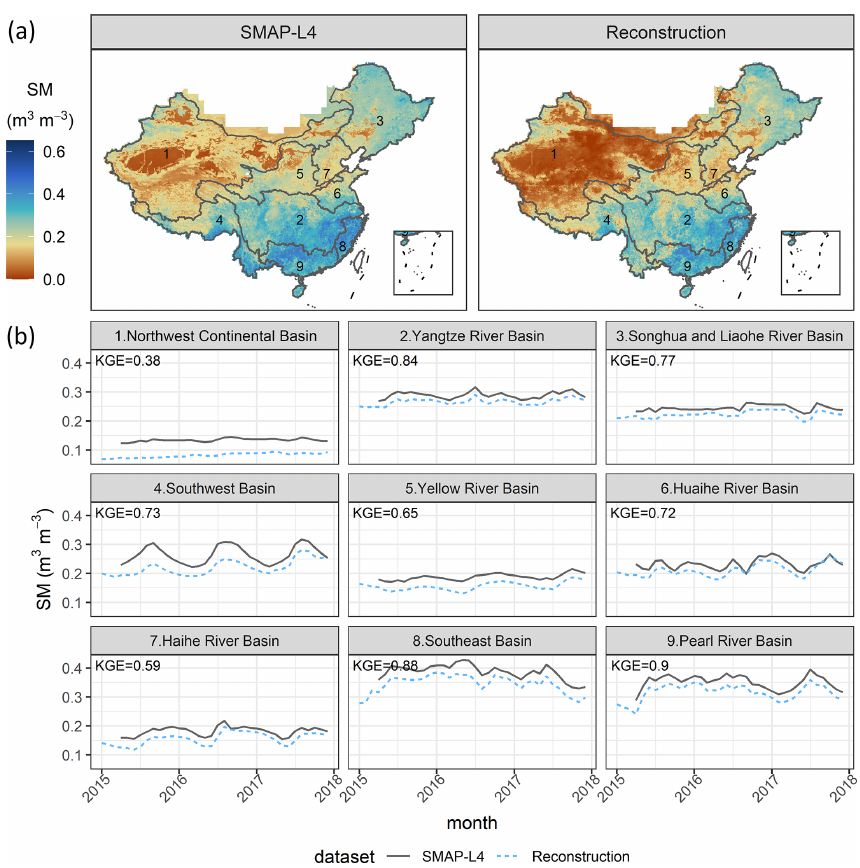
Figure 9. (a) Map of daily average soil moisture (SM) of SMAP-L4 and reconstruction in 2015–2017. (b) Time series of the daily average SM of SMAP-L4 and reconstruction for nine major river basins in each month of